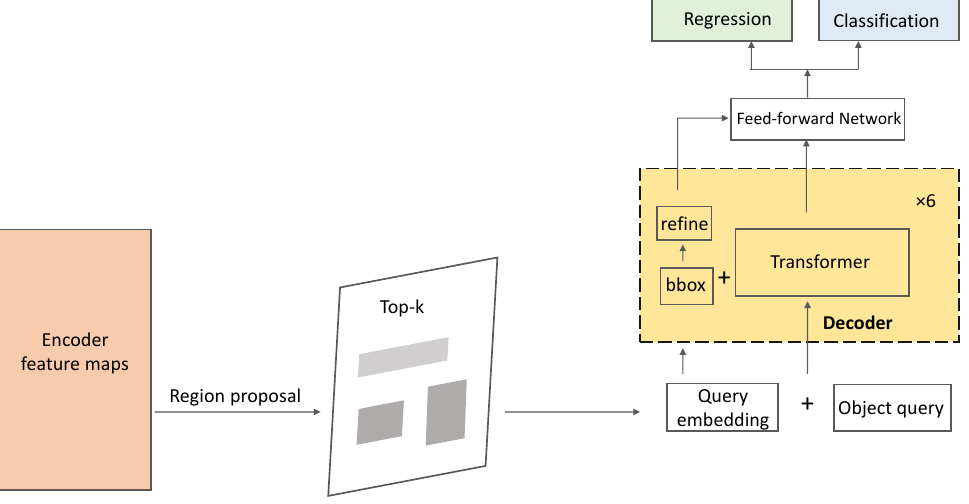
Figure 3. The details of the two-stage transformer with GhostNet in an encoder and a decoder